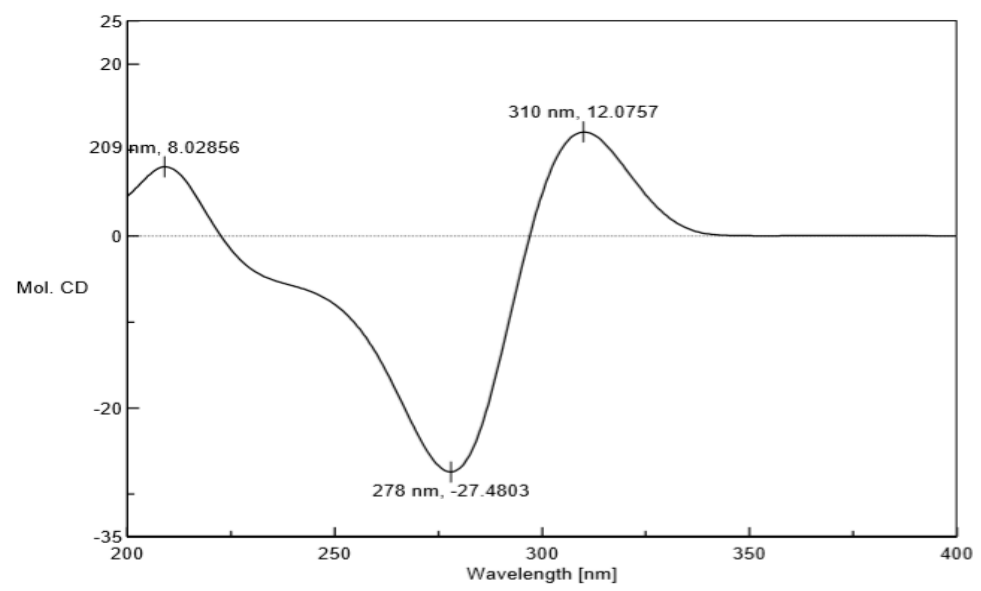
Figure 6. Experimental ECD spectra of 2 in methanol.